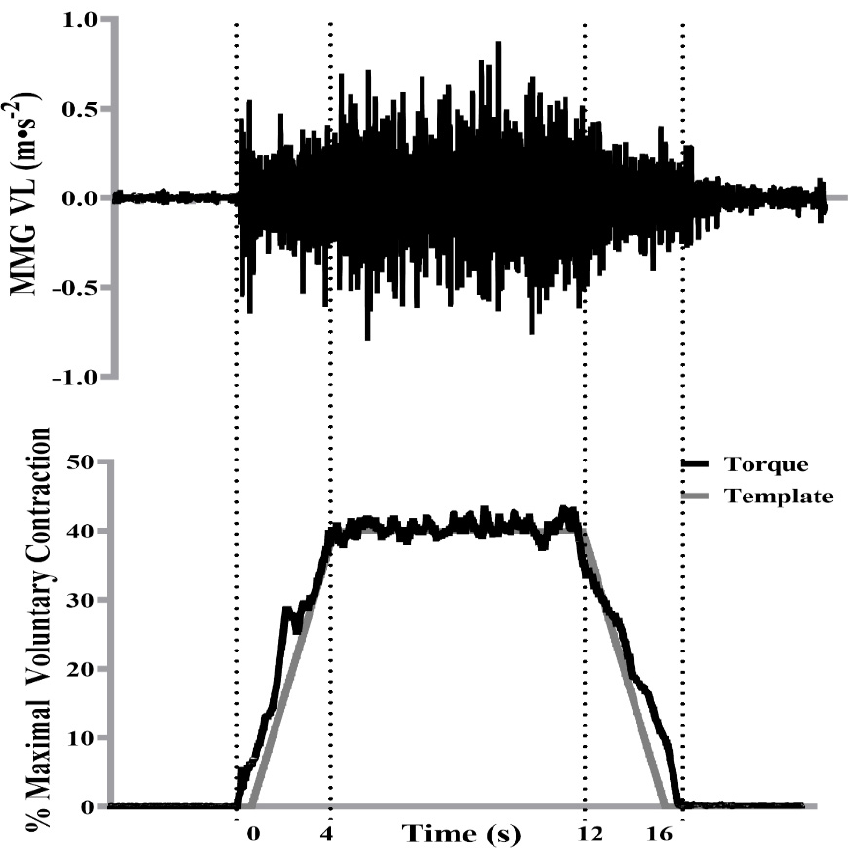
Figure 1. Top: illustration of a mechanomyographic (MMG) signal recorded from the vastus lateralis (VL) for one participant during a 40% isometric trapezoidal muscle action. Bottom: the torque signal is superimposed over the targeted torque template as it appeared during testing.